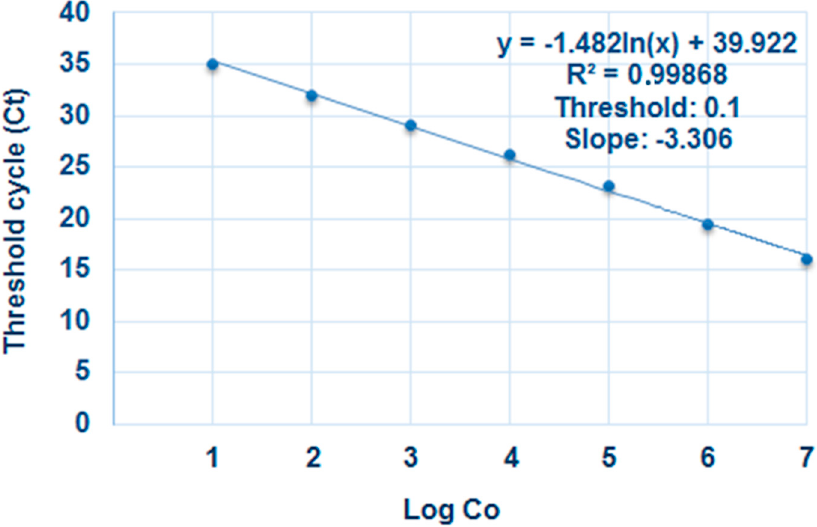
Figure 4. Standard curve using known copies (10 1 to 10 7 ) of the appropriate cloned target sequence of the Aphanomyces euteiches specific gene (GenBank accession No. AF228037.1). For each reaction, the cycle threshold (Ct), the initial cycle number at which an increase in fluorescence above a baseline can be detected, is plotted against the log10 (Log Co) of the A. euteiches specific gene copies. Three technical PCR replicates were performed for each concentration.